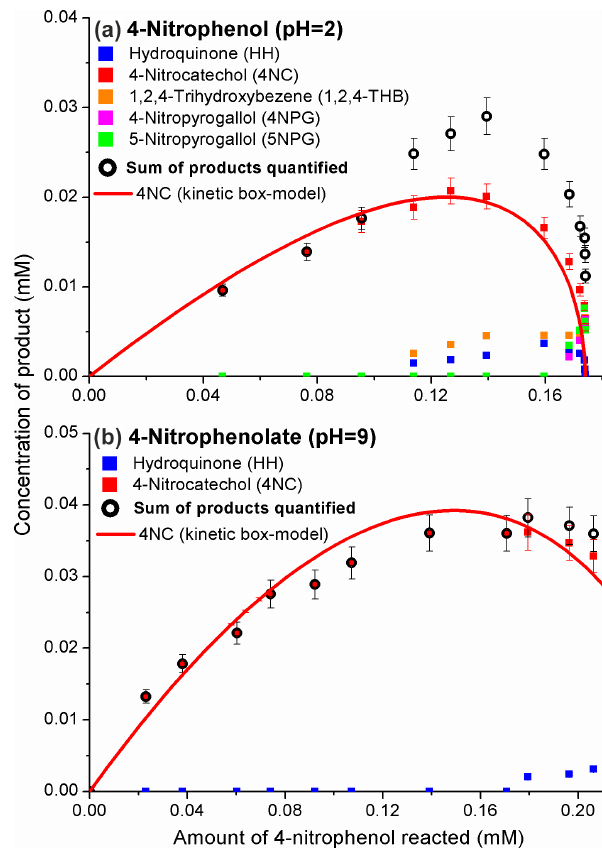
Figure 2. The formation of phenolic products from the 4- nitrophenol ( a , pH = 2) and 4-nitrophenolate ( b , pH = 9) + OH re- action. The molar yields for 4NC were estimated from the initial sections of the plots via linear regression analysis (Fig. S4 and Ta- ble S2). Plots derived with Eq. (1) for the products quantified are expected to curve during the course of the reaction because these molecules are also reactive towards OH. The lines for 4NC are re- sults of kinetic modeling (Table S3 and Fig.